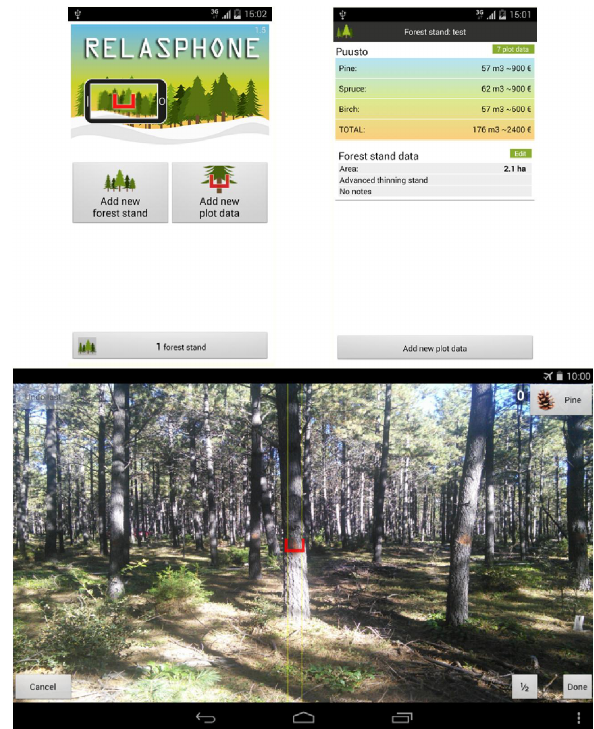
Figure 1: Relasphone application for in-situ forest inventory data collection. Main screen, relascope view, and forest plot summary (biomass and